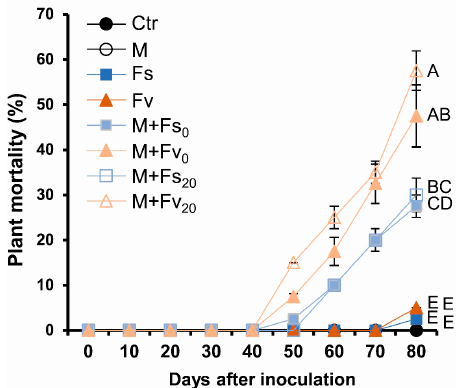
Fig. 6: Percentage plant mortality of inka nut plants at the presence of Meloidogyne incognita and Fusarium spp. measured at 10-day inter- vals for 80 days. Error bars indicate standard deviation (± S.D.). Columns with the same letter are not significantly different ( p